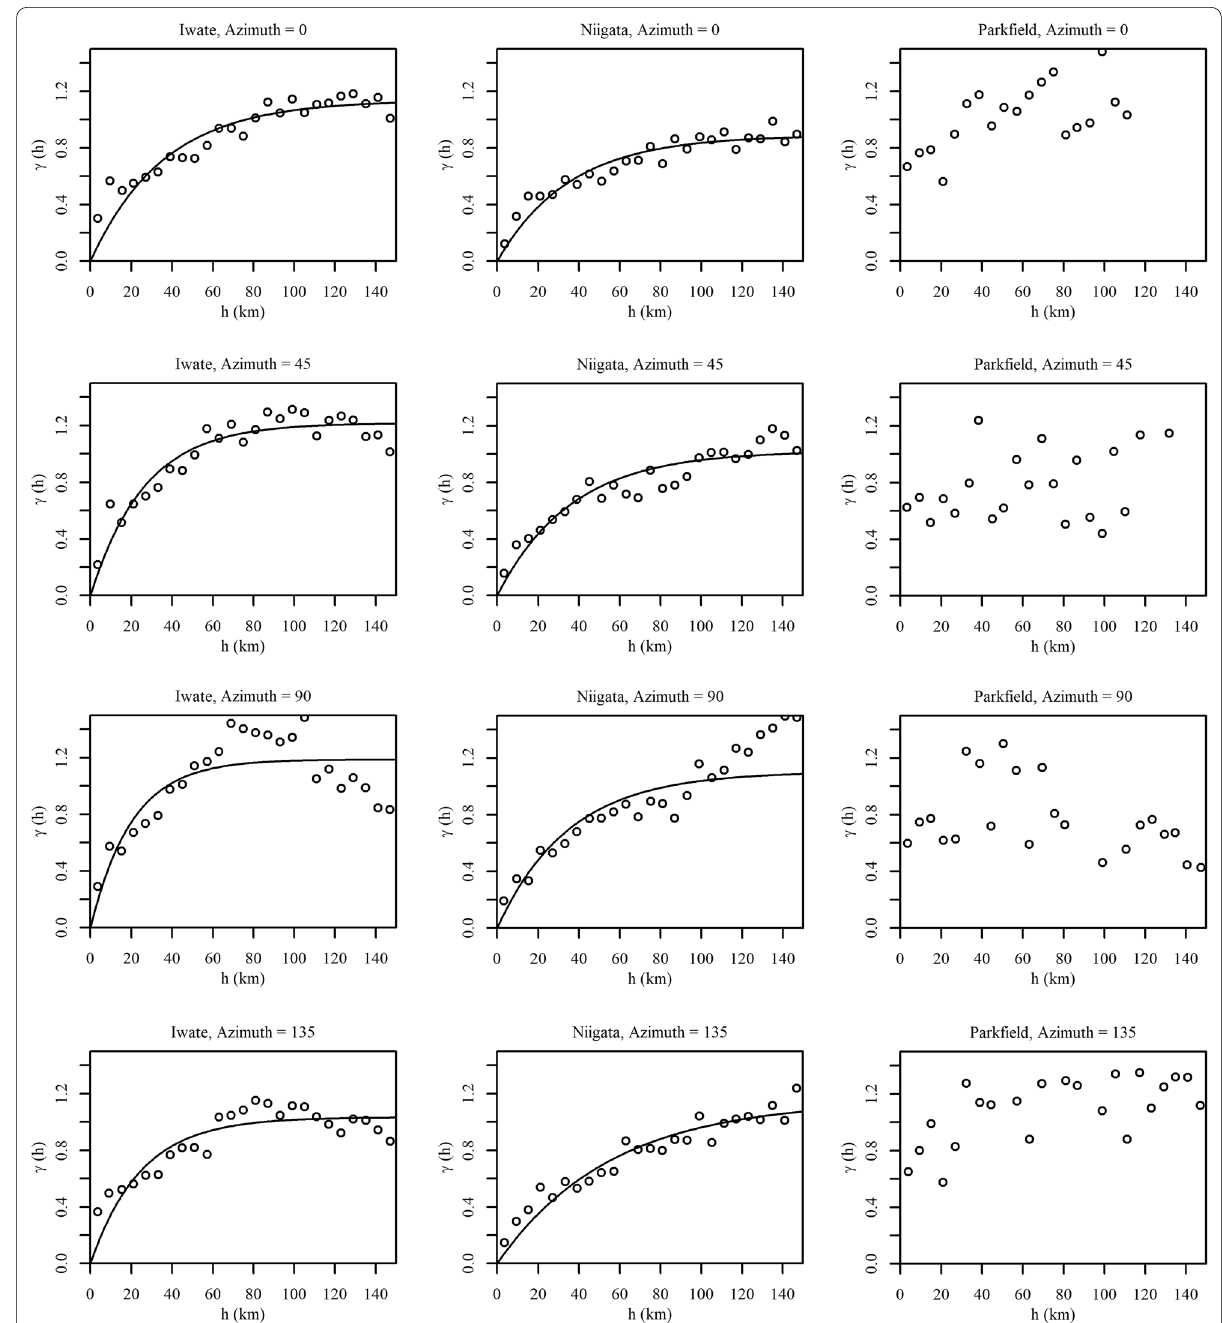
Fig. 4 Experimental and fitted directional semivariogram of residuals of PGV at recording stations of 2008 Iwate, 2004 Niigata and 2004 Parkfield